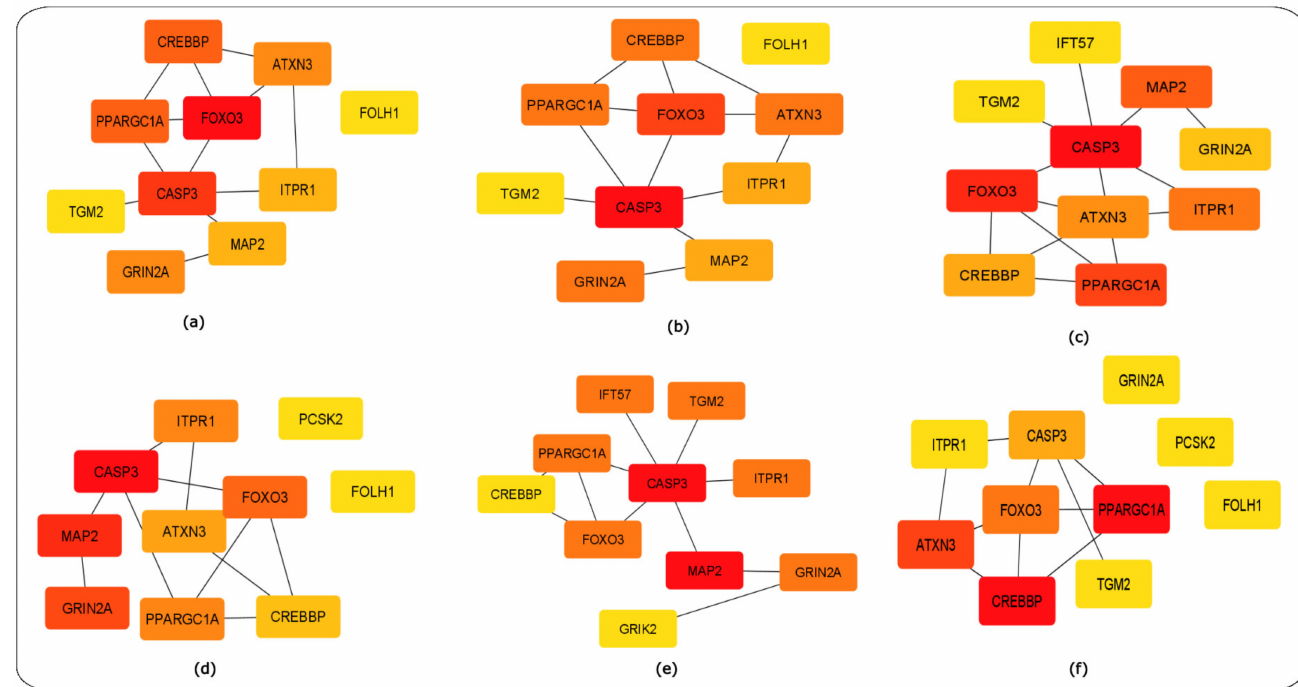
Figure 13. CytoHubba analysis results of the 18 HD-related hub genes. Red- to yellow-coloured Cy- toHubba nodes represent highest- to lowest-ranked nodes based on the topological approach applied.